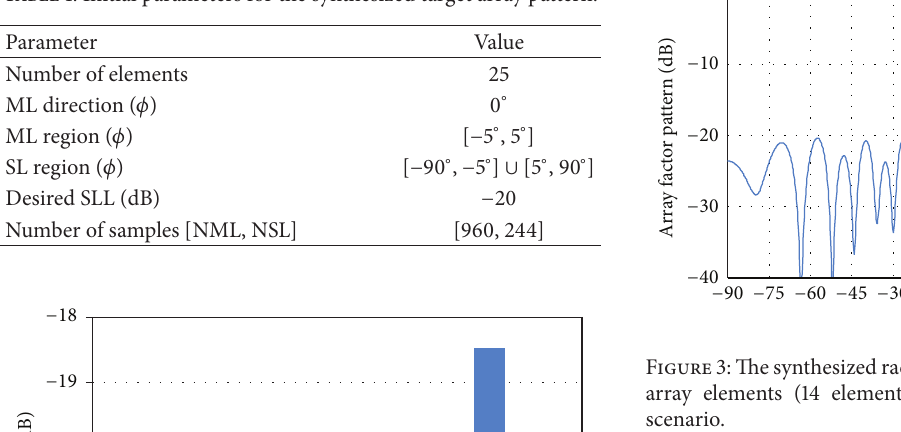
Table 1: Initial parameters for the synthesized target array pattern.